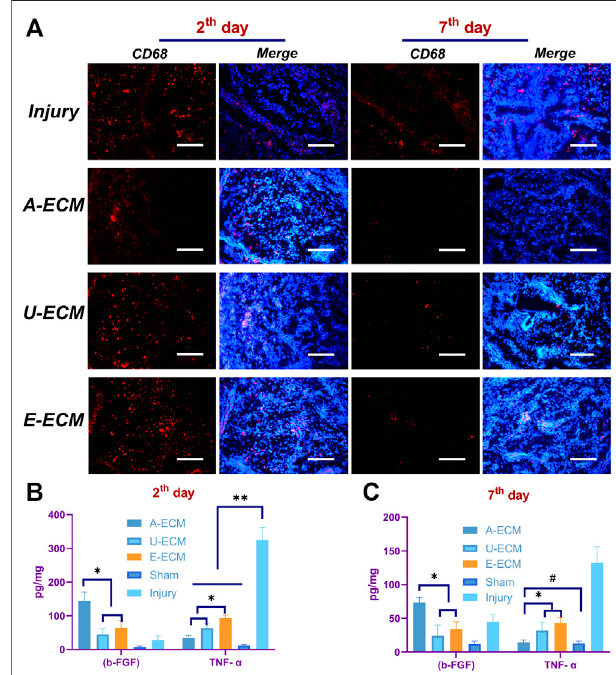
FIGURE3| Localandsystemicin fl ammatoryconditionsinthebodyafter d-ECM implantation. (A) Local CD68 expression (macrophage indicator) at postoperative day 2 and 7 in all groups and quantitative comparison of the proin fl ammatory cytokine and anti-in fl ammatory cytokine levels at the correspondingtimepoints (B,C) .* p < 0.05,** p < 0.01,and # p > 0.05,one-way ANOVA with Tukey ’ s post hoc test. Bar = 50 μ